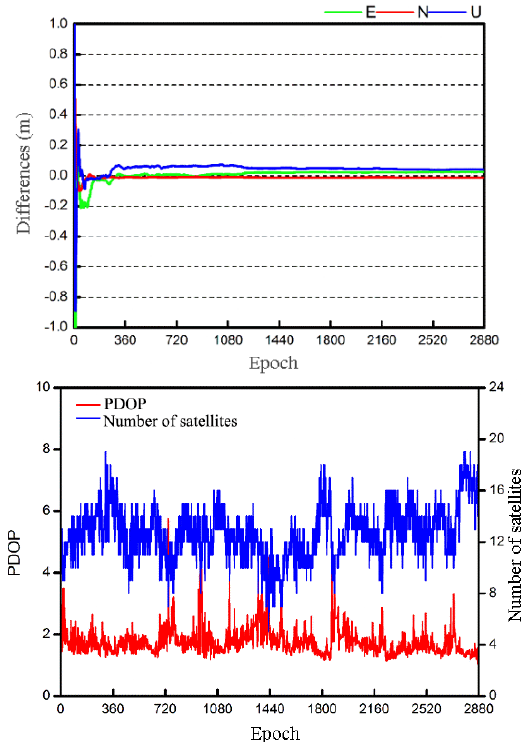
Figure 7. Position deviation and observation of G/R/E combined PPP.